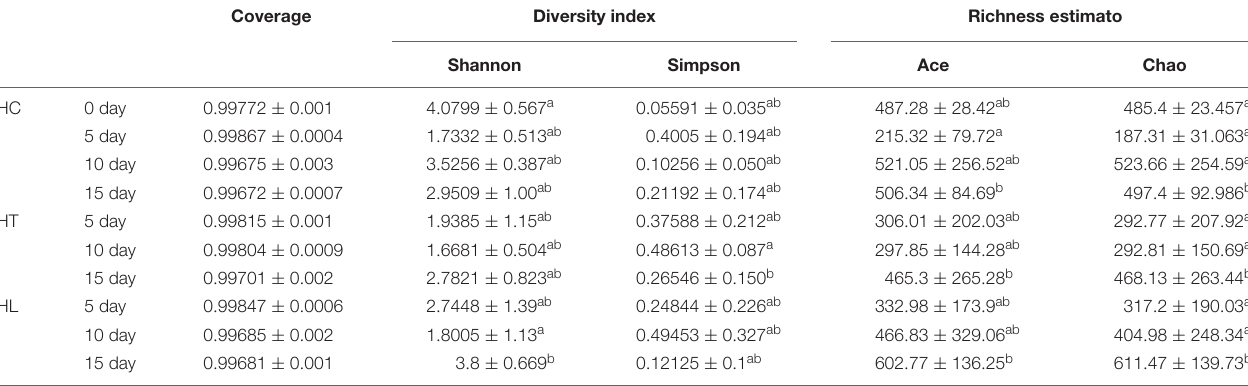
TABLE 3 | Alpha diversity indices of intestinal microbiota based on OTU levels in every group of crucian carp under water temperature decrease. Coverage Diversity index Richness